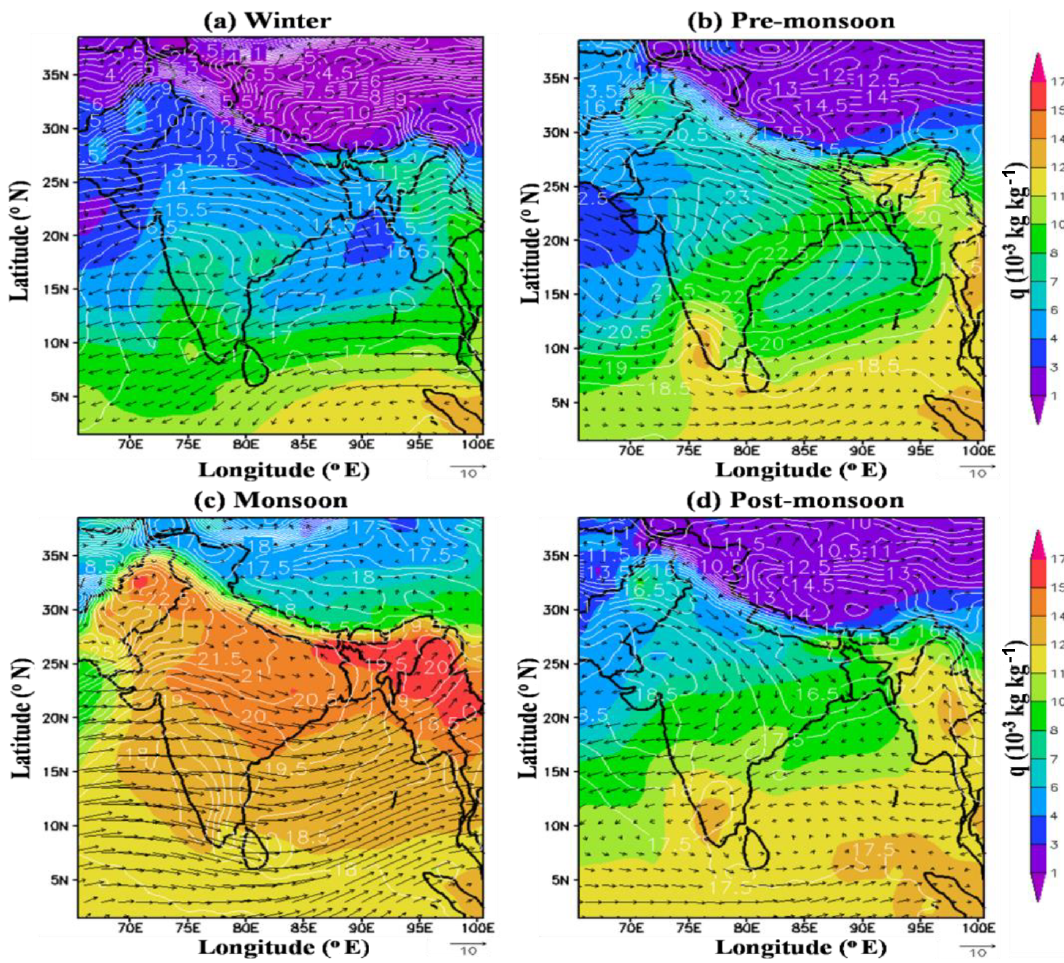
Figure 2. Seasonal composite of ECMWF wind, temperature and humidity fields over India during